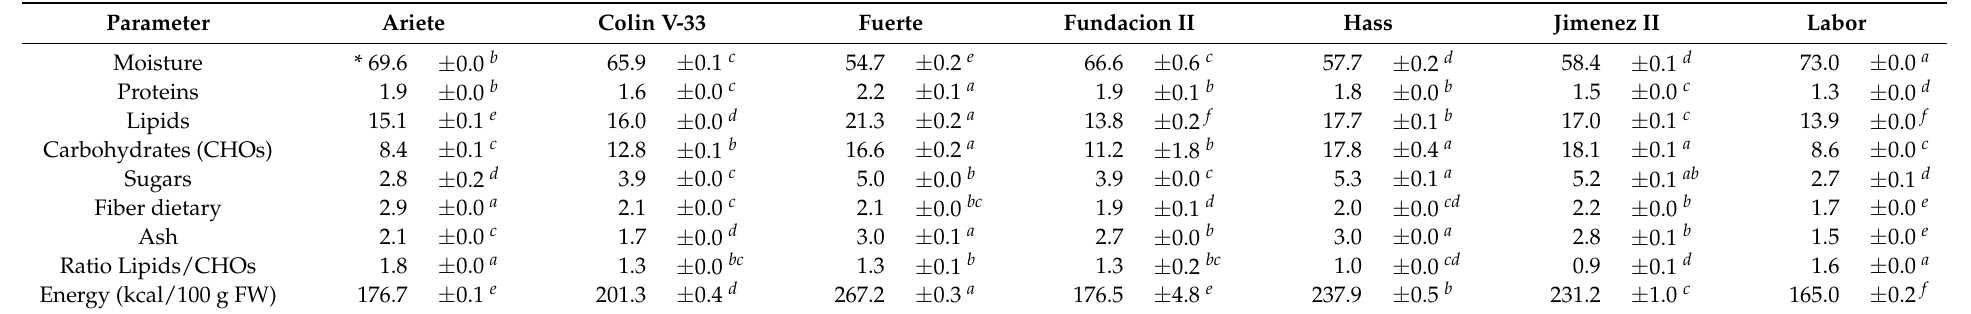
Table 3. Proximate macronutrient concentrations (g/100 g fresh weight (FW)) of seven avocado cultivars, including commercial and non-commercial samples. Parameter